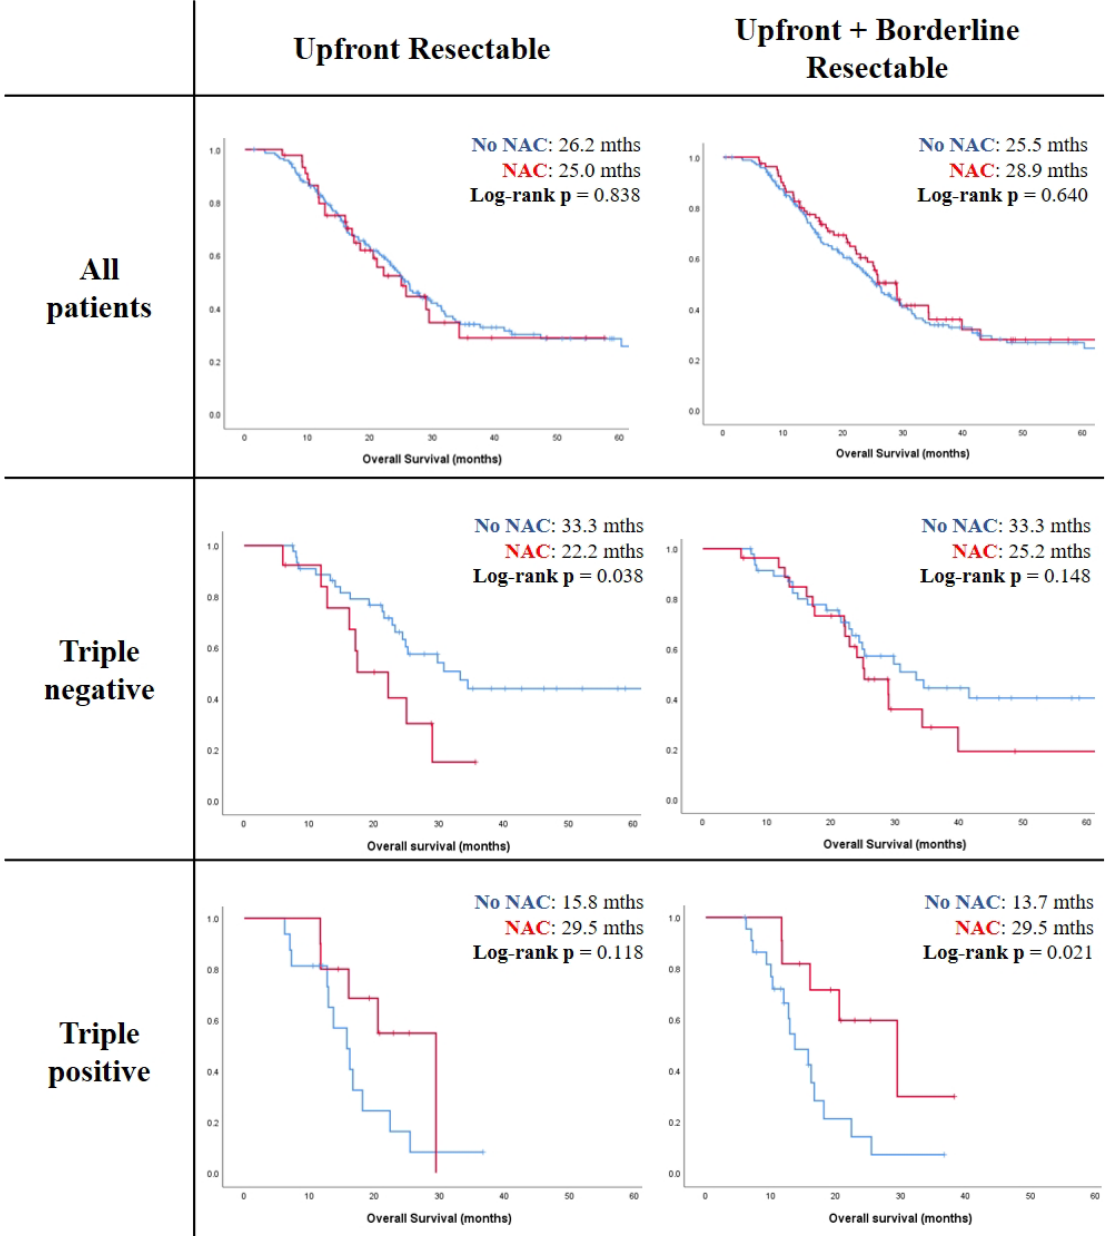
Figure 1. Influence of triple biomarker expression on survival outcomes after a neoadjuvant vs. surgery-first treatment strategy in the RNSH cohort: NAC, neoadjuvant chemotherapy; resectable PDAC cohort, n = 192; resectable + borderline resectable cohort, n = 252.